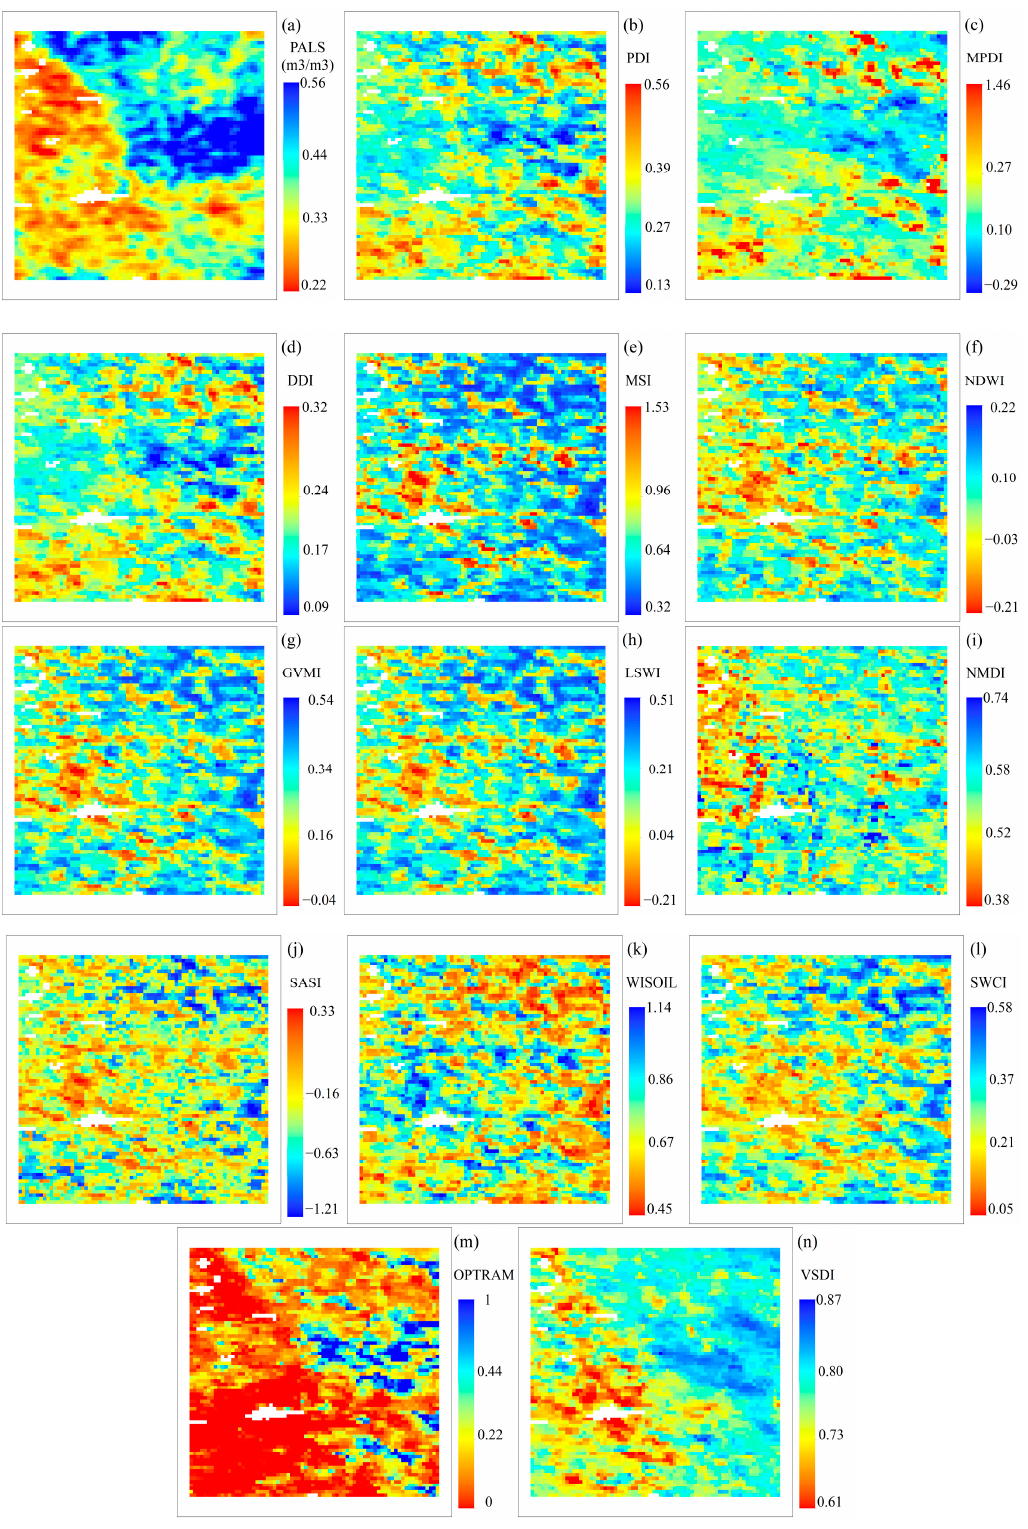
Figure 2. Spatial distribution of the aircraft SM and optical SM indexes during the SMAPVEX16 Manitoba experiment on 19 June 2016 where ( a ) is the aircraft SM and ( b – n ) are the thirteen optical SM indexes.